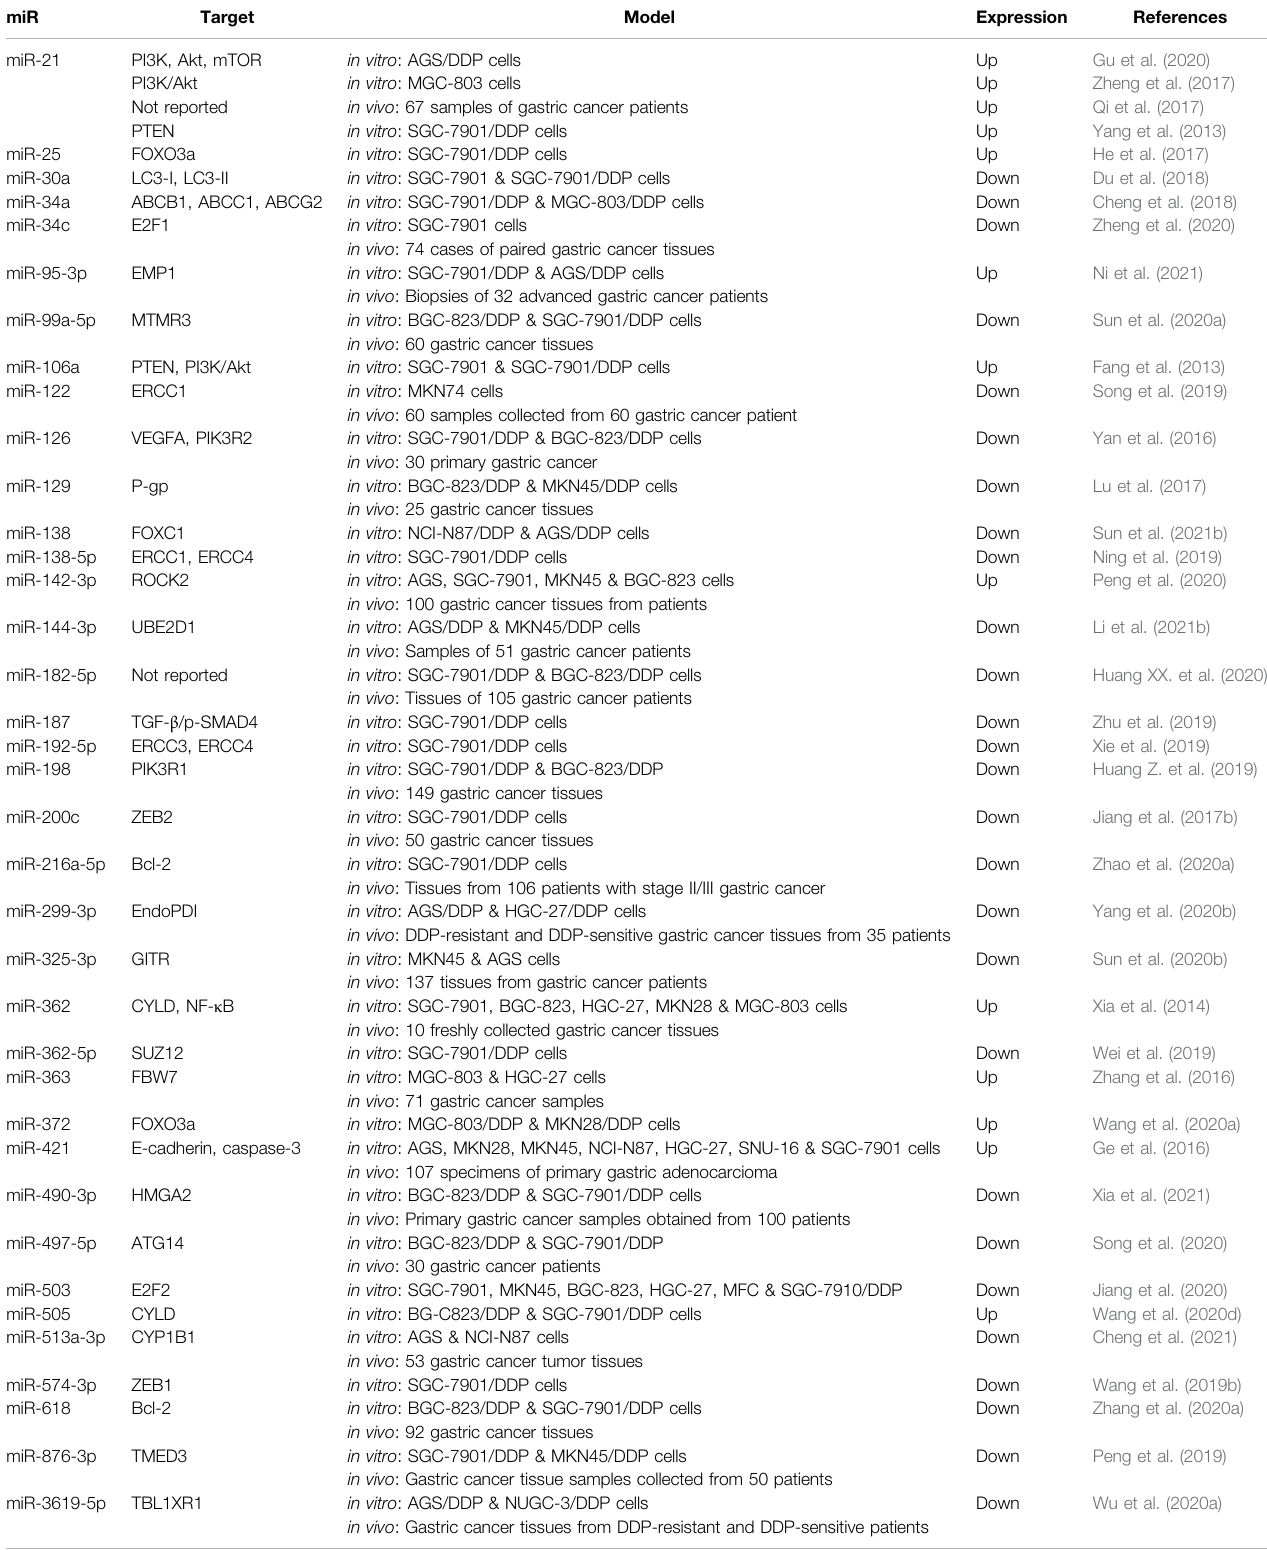
TABLE 3 | MicroRNAs involved in DDP-chemoresistance of stomach